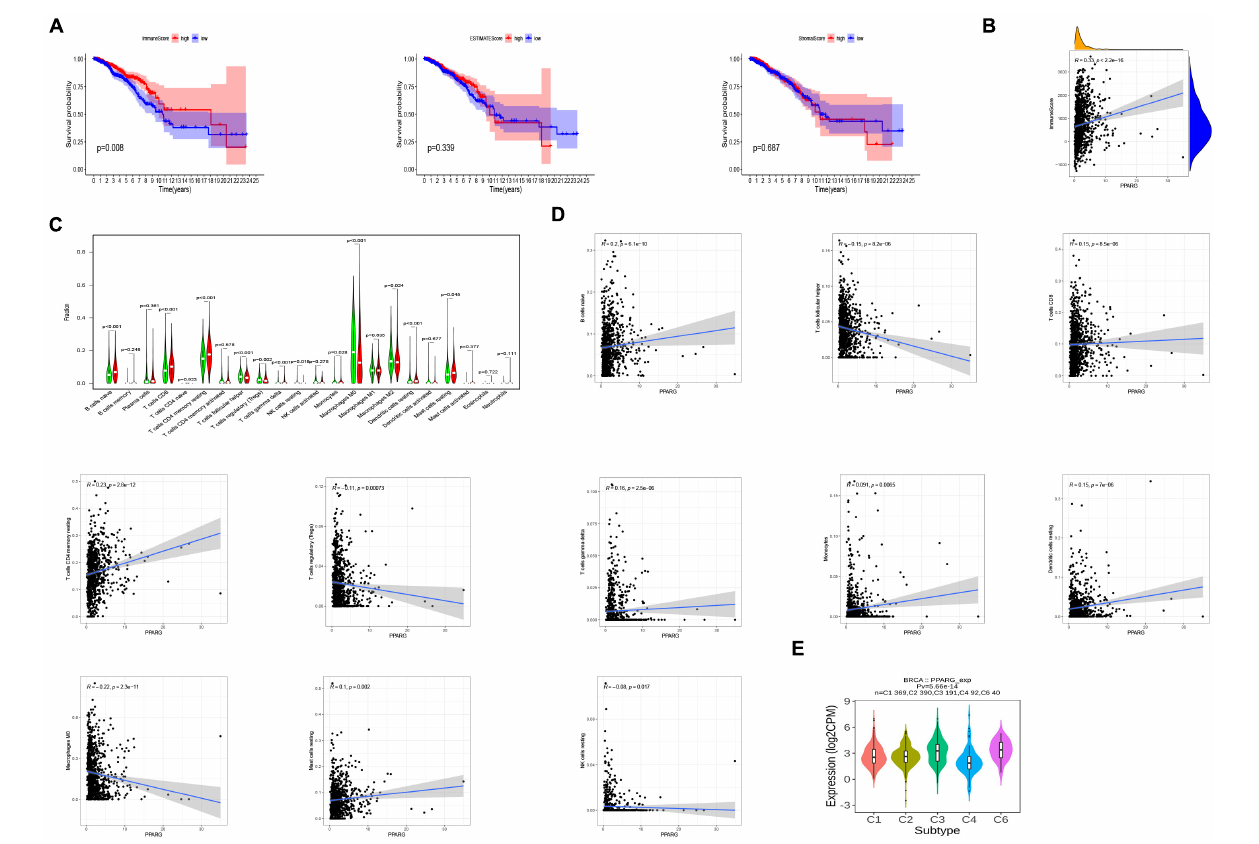
FIGURE 6 | Relationship between PPARG and the tumor-immune microenvironment. (A) Evaluate the immune microenvironment of TCGA-BRCA through the ESTIMATE algorithm. (B) Correlation analysis between PPARG expression level and immune score. (C) Evaluate the level of immune cells between the high- (red) and low- (green) PPARG expression groups through the CIBERSORT algorithm. (D) Correlation analysis between PPARG and immune cells. (E) The expression of PPARG of different immune subtypes in BRCA was evaluated by TISIDB.